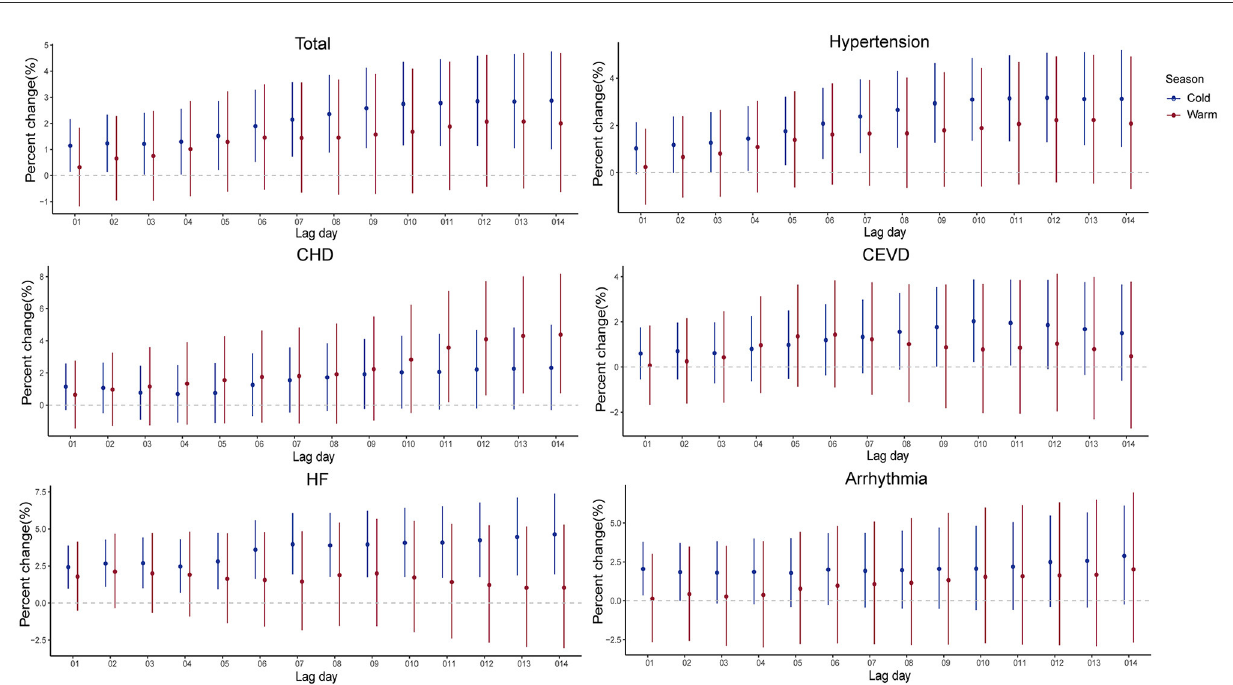
FIGURE5 Percent changes and 95% confidence intervals (CIs) of daily hospital admissions for total and cause-specific circulatory system diseases by each 10 µ g/m 3 increase of PM 2.5 concentrations stratified by season in the cumulative-day lag models. HBP, hypertension; CHD, Coronary Heart Disease; CEVD, Cerebrovascular Disease; HF, Heart